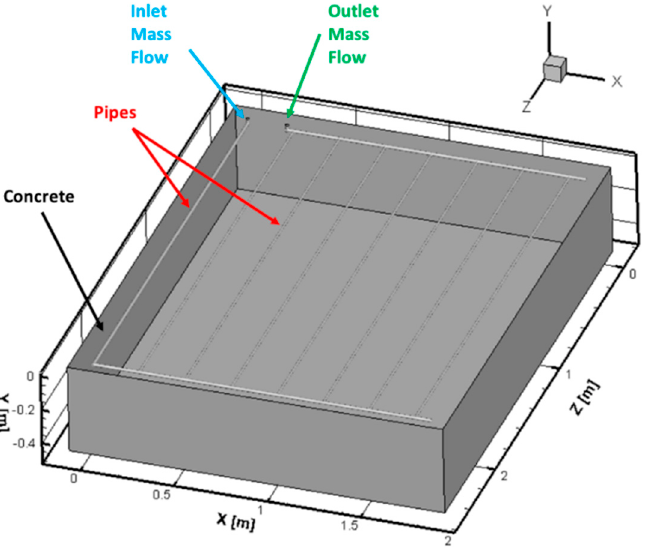
Figure 5. Numerical model geometry.